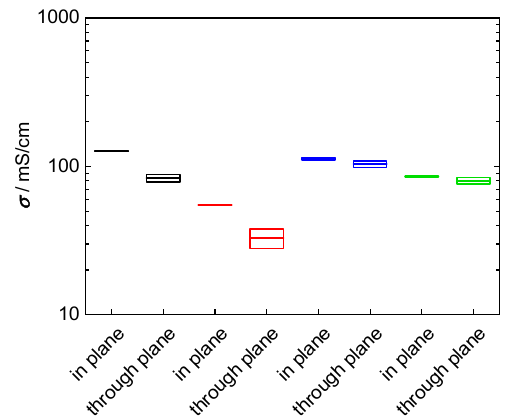
Figure 13. Comparison of in-plane and through-plane conductivity at room temperature in water: black: 3M 825 EW with 5 wt% glass platelets; red: 3M 825 EW with 10 wt% glass platelets; blue: 3M 825 EW (100 µm); and green: Nafion 117.